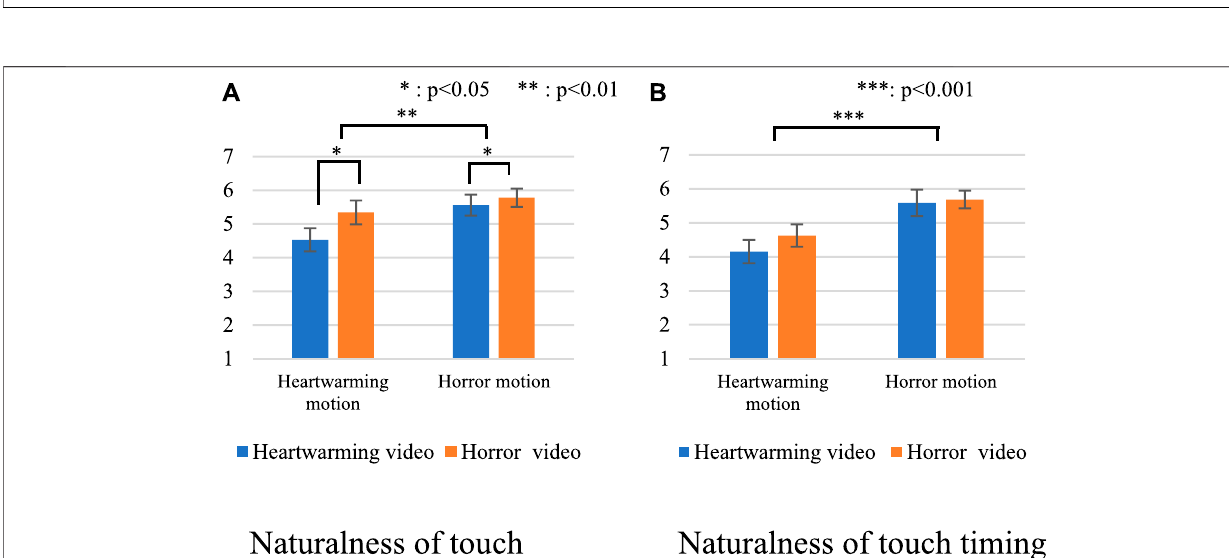
FIGURE 6 | Questionnaire results with only new videos. (A) Naturalness of touch. (B) Naturalness of touch timing.